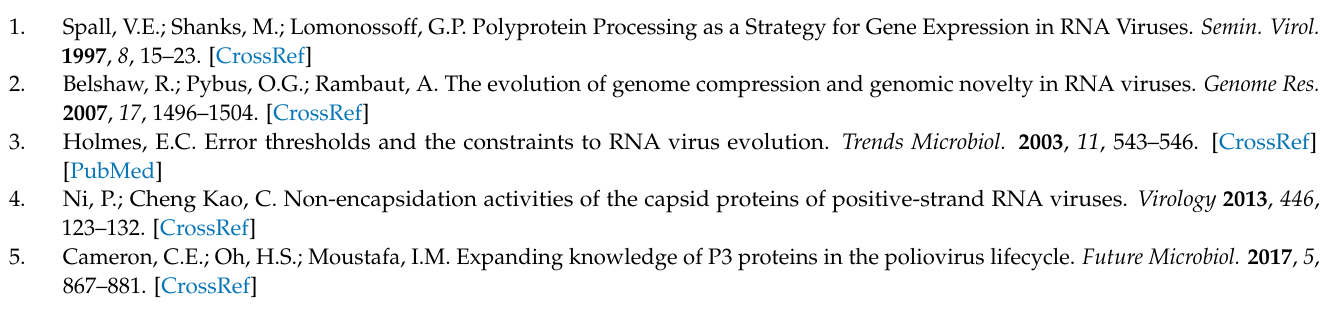
915/13/3/442/s1, Supplementary Methods: Validation of rotational correlation time τ c by TRACT, Figure S1: Multiple quantum 1 H- 13 C CPMG relaxation dispersion plots for δ 1-methyl Ile groups in the 3C protein, Figure S2: 1 H CEST profiles for δ 1-methyl Ile groups in the 3C protein, Figure S3: 13 C CEST profiles for δ 1-methyl Ile groups in the 3C protein, Figure S4: Nonlinear fits for the intramethyl 1 H- 1 H cross-correlated relaxation (eta), including the correction for dipolar interactions with external protons (delta) for δ 1-methyl Ile groups in the 3C protein, Figure S5: Fitted 1 H- 15 N TRACT results for determination of τ c for 3C, Figure S6: Multiple quantum 1 H- 13 C CPMG relaxation dispersion plots for δ 1-methyl Ile groups in the 3C domain of the 3CD protein (i.e., 3C * D), Figure S7: 1 H CEST profiles for δ 1-methyl Ile groups in the 3C domain of the 3CD protein (i.e., 3C * D), Figure S8: Nonlinear fits for the intramethyl 1 H- 1 H cross-correlated relaxation (eta), including the correction for dipolar interactions with external protons (delta) for δ 1-methyl Ile groups in the 3CD protein, Figure S9: Multiple quantum 1 H- 13 C CPMG relaxation dispersion plots for δ 1-methyl Ile groups in 3D protein, Figure S10: 1 H CEST profiles for δ 1-methyl Ile groups in the 3D protein, Figure S11: Nonlinear fits for the intramethyl 1 H- 1 H cross-correlated relaxation (eta), including the correction for dipolar interactions with external protons (delta) for δ 1-methyl Ile groups in the 3D protein, Figure S12: Multiple quantum 1 H- 13 C CPMG relaxation dispersion plots for δ 1-methyl Ile groups in the 3D domain of the 3CD protein (i.e., 3CD * ), Figure S13: 1 H CEST profiles for δ 1-methyl Ile groups in the 3D domain of the 3CD protein (i.e., 3CD *